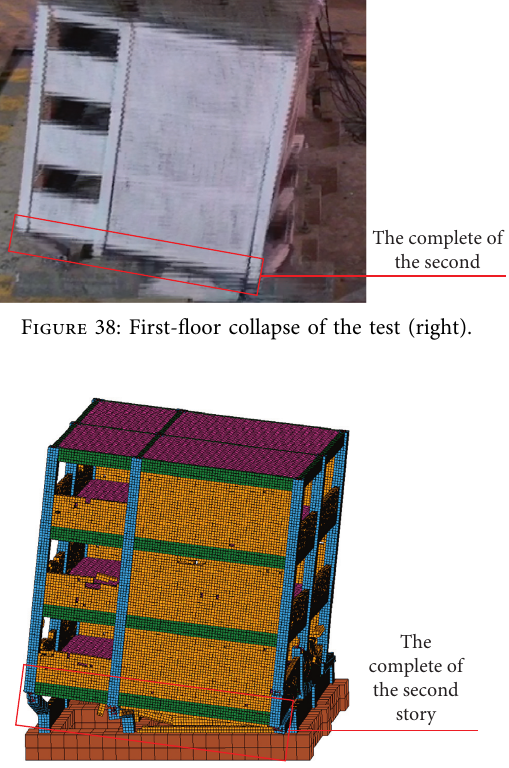
Figure 36: First-floor failure state of the test (right).